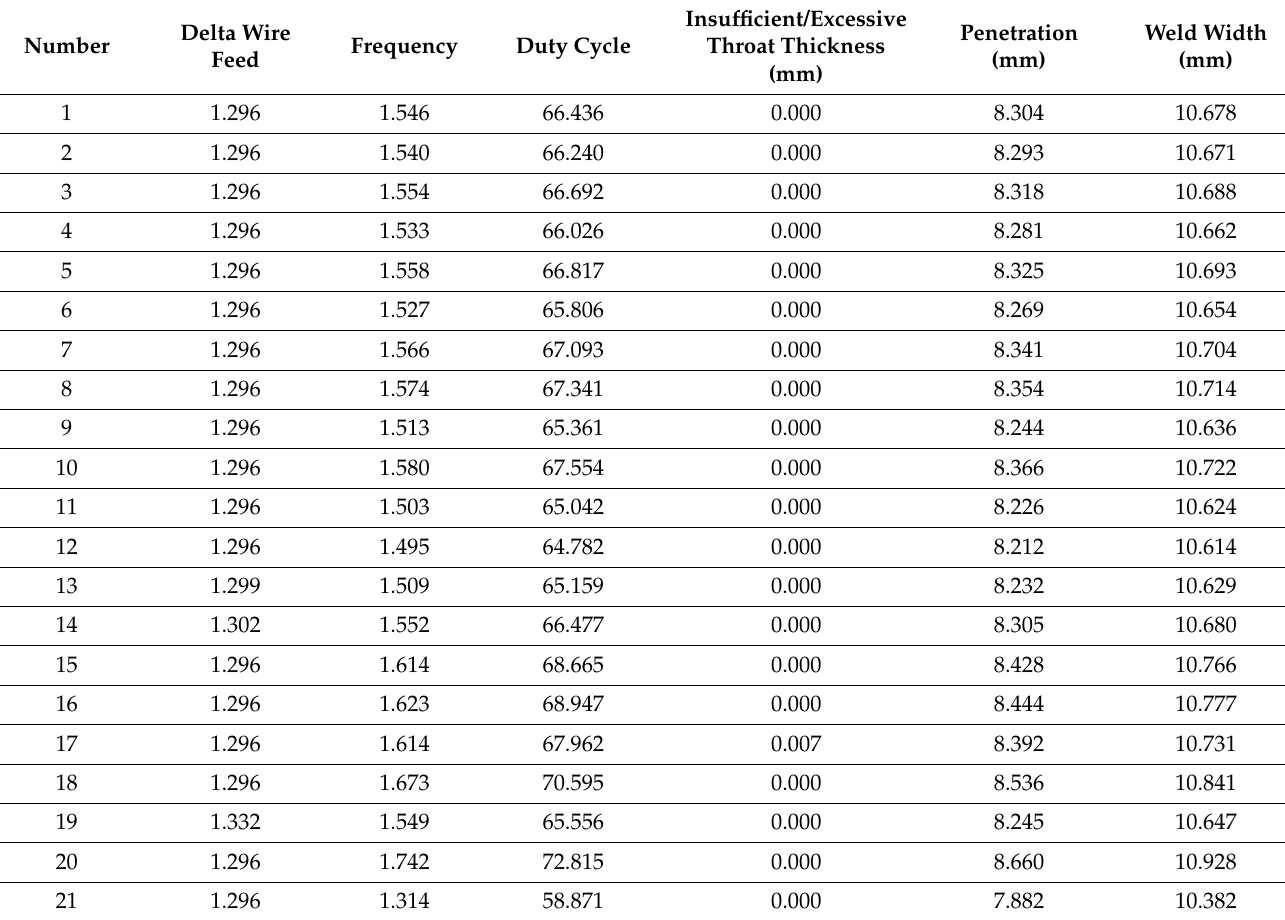
Table 15. Solution for five combinations of input